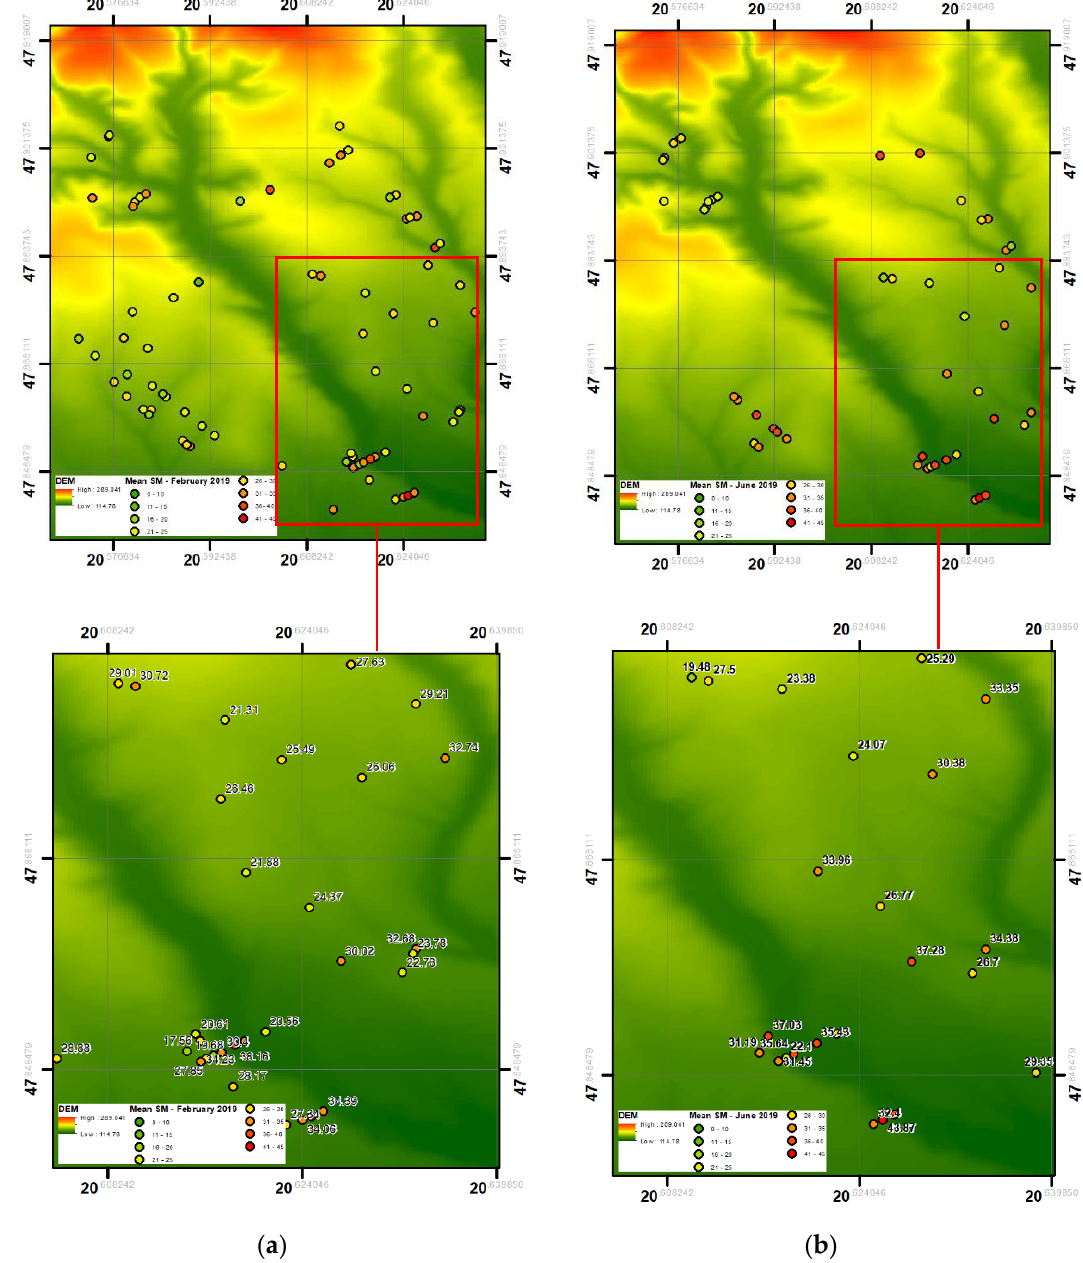
Figure 6. ( a ) Mean soil moisture (V%) in February 2019—dry season and ( b ) mean SM (V%) in June 2019—wet season.